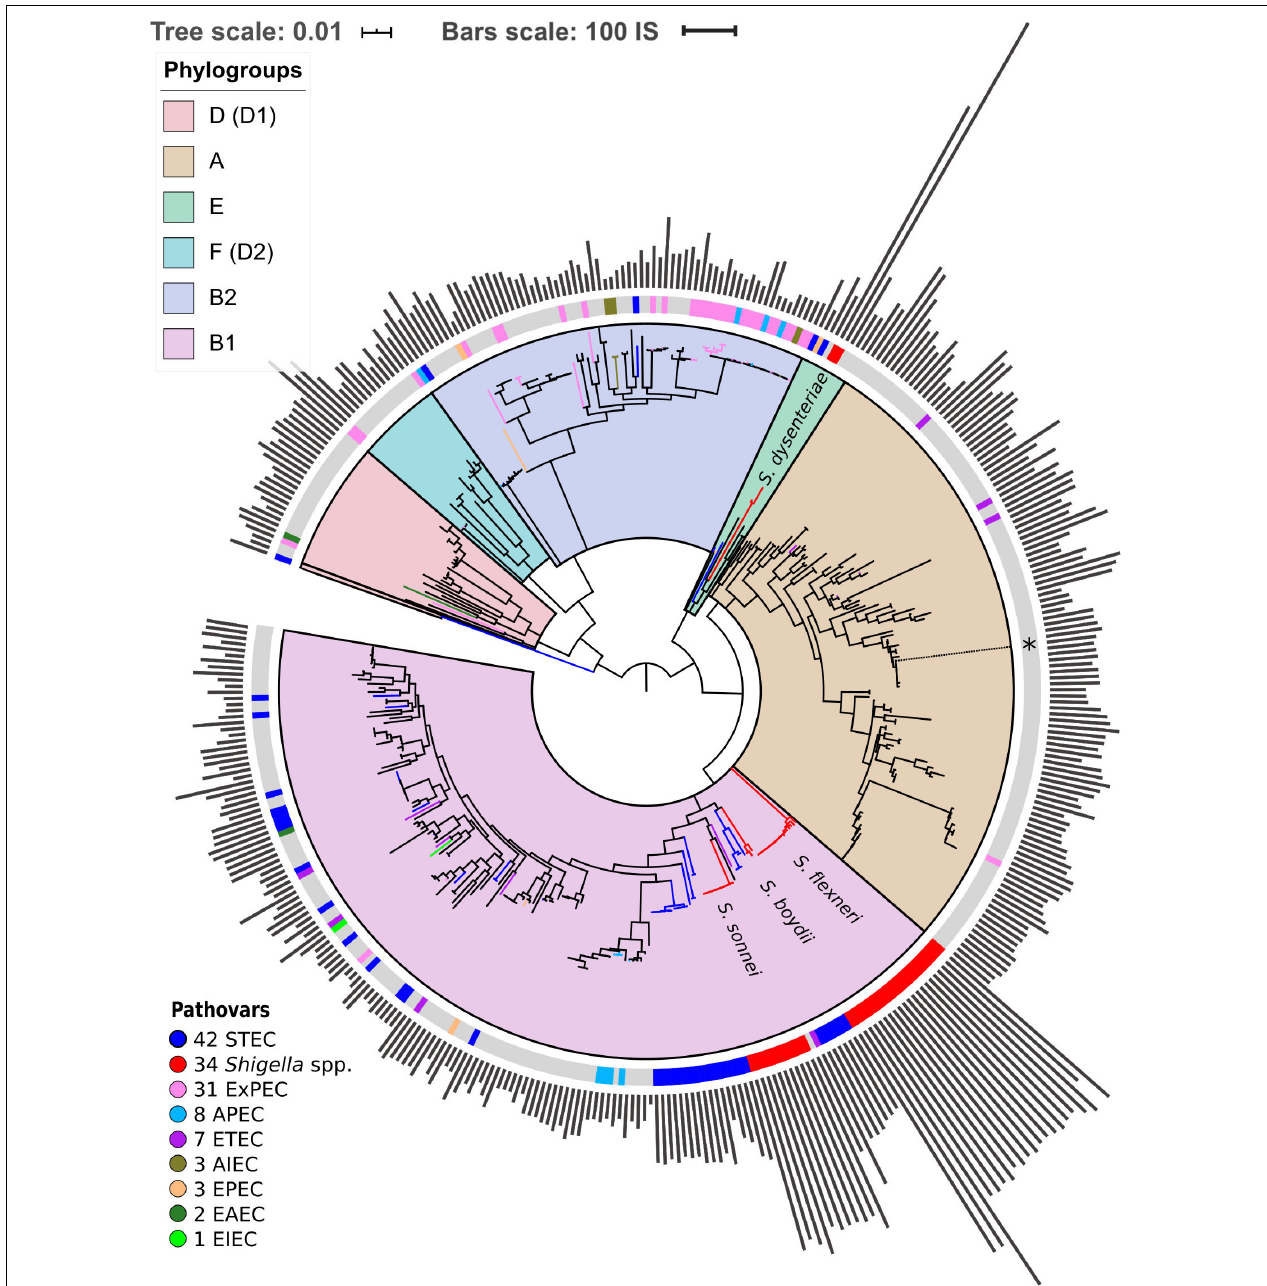
FIGURE 1 | Phylogenetic tree of Escherichia coli and Shigella spp. The tree is based on the nucleotide alignment of universal single-copy orthologs. Clusters and corresponding phylogroups are shown in different colours; the number of genomes of each pathovar is indicated to the right of the pathovar’s name. Pathogenic E. coli strains are marked with coloured bands on the outer circle. The location of the unclassified Shigella strain is shown with an asterisk. The bars indicate the number of ISs found by ISsaga in bacterial chromosomes. The tree is unrooted.